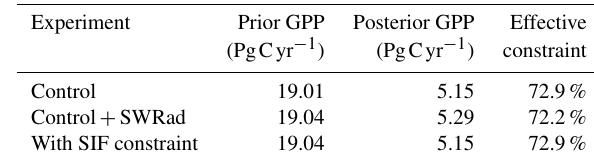
Table 2. Parametric uncertainty and effective constraint of global annual GPP for each of the SWDown experiments. Prior and pos- terior values shown are the 1 standard deviation ( σ ) uncertainty in global annual